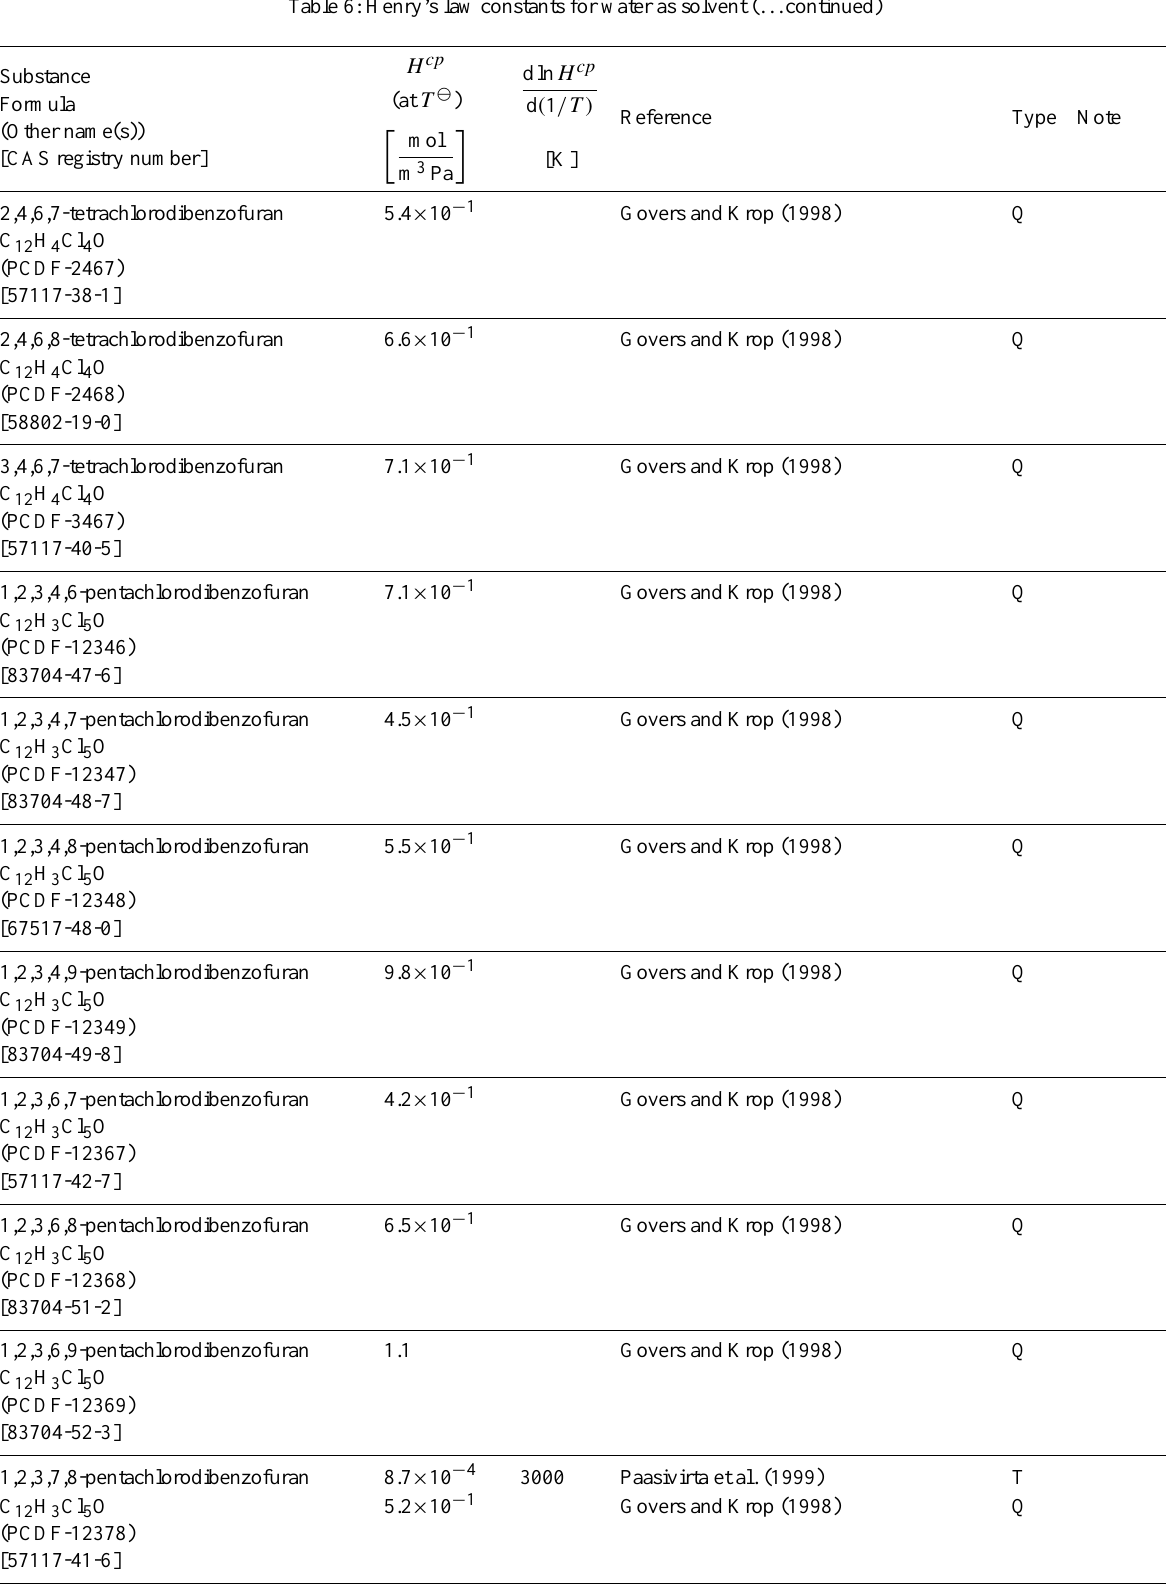
Table 6: Henry’s law constants for water as solvent